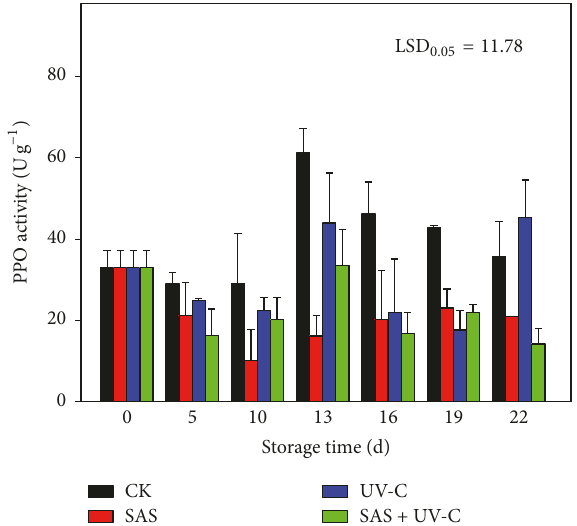
Figure 4: Effects of SAS, UV-C, and SAS + UV-C on PPO activity of fresh-cut potatoes during storage. The error bars represent the standarddeviation.LSDsrepresentleastsignificantdifferencesatthe 0.05 level.